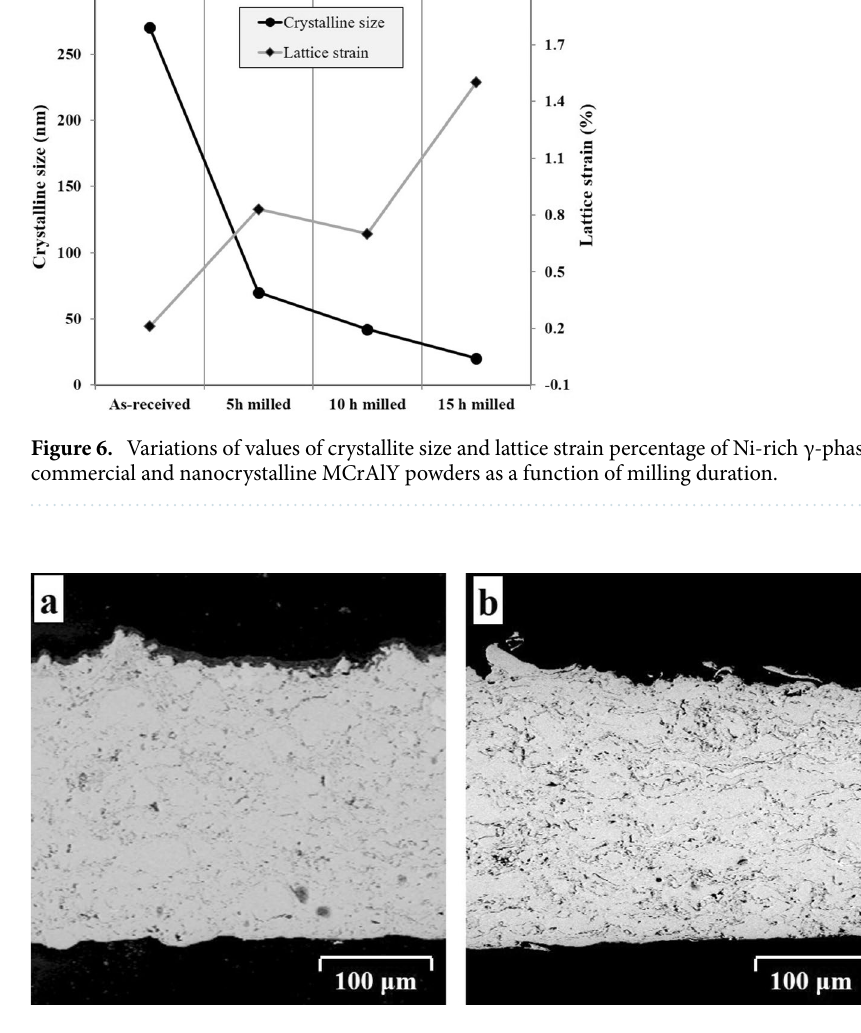
Figure 7. Backscattered electron images of ( a ) as-received MCrAlY coating and ( b ) nanocrystalline MCrAlY coatings developed using powder feedstock after 15 h of ball-milling